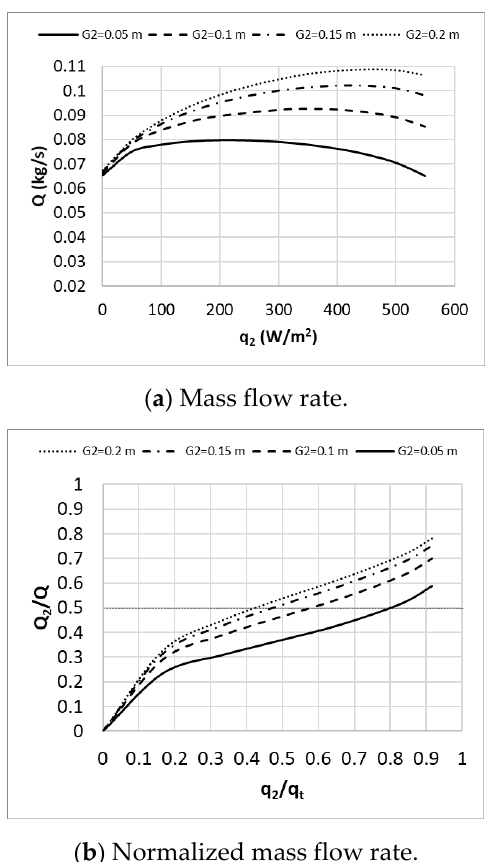
Figure 10. The flow rate at different gaps 𝐺 2 for Configuration (II).